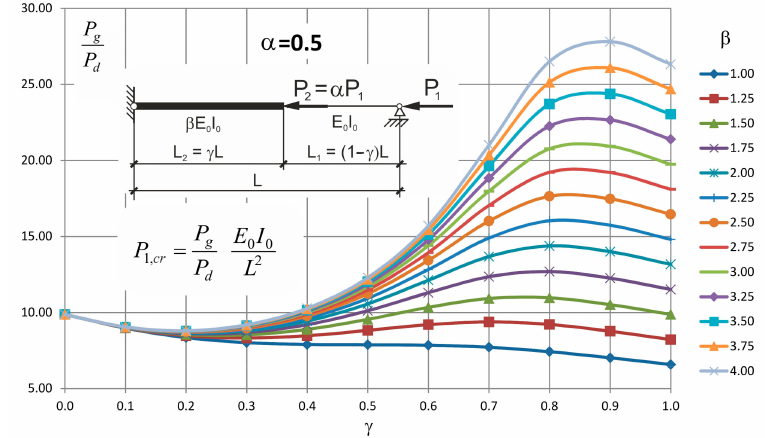
Figure 6. Values P g /P d for α = 0.5 and for different values of β and γ .